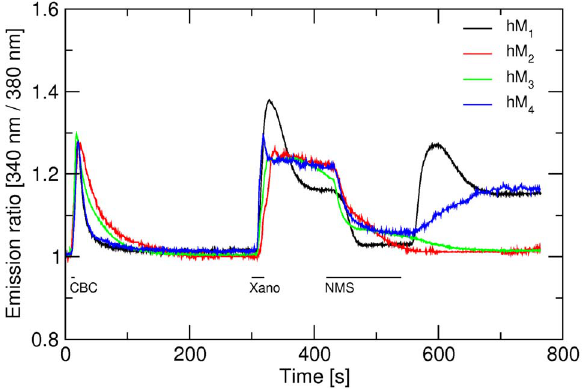
Figure 5. Effects of NMS on formation of xanomeline wash- resistant activation at hM 1 through hM 4 receptors. Changes in the concentration of intracellular calcium (ordinate) are expressed as changes in normalized fluorescence intensity (340 nm/380 nm) ratio normalized to basal calcium level. First (control) stimulation: Control 300 nM carbachol (CBC) was applied for 5 s. Second stimulation: At 5 min receptors were blocked by 10 m M of the antagonist NMS (1 min), then a mixture of 10 m M xanomeline (Xano) and 10 m M NMS was applied for 1 min and then 10 m M NMS was applied for an additional 1 min. Cells were then washed with KHB for additional 3 min. Representative traces are averages of 8 to 12 best responding cells from one experiment. Signal variation (SD) among cells ranges from 6 0.015 at the base line to 6 0.033 at peaks. Results were confirmed in 5 to 7 additional independent experiments. Parameters of xanomeline effects are summarized in Table S7 in File S1.